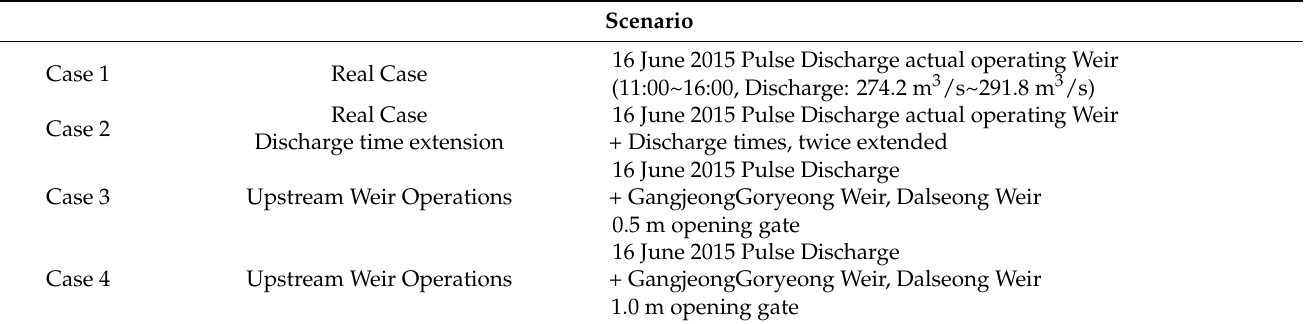
Table 1. Scenario Simulations of the Operating Weir.